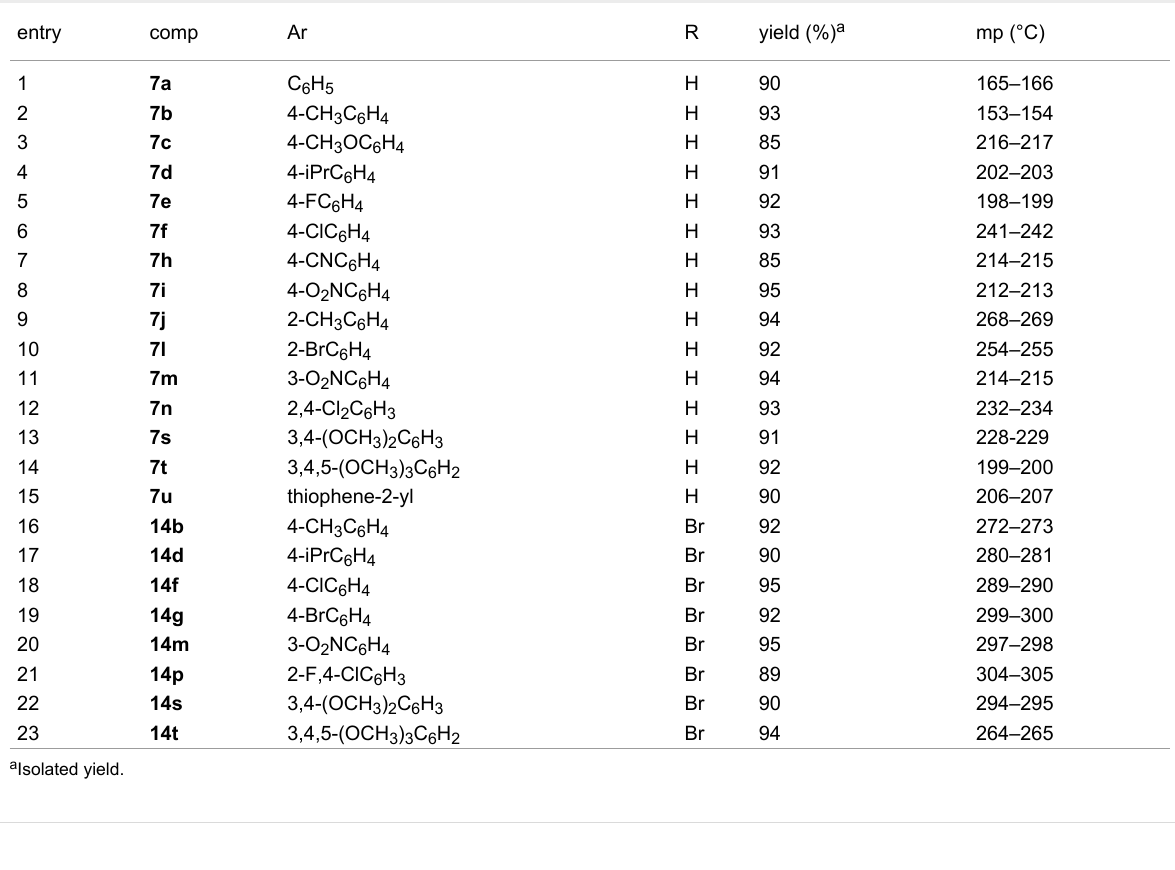
Table 2: Yields and melting points of 7 and 14 .